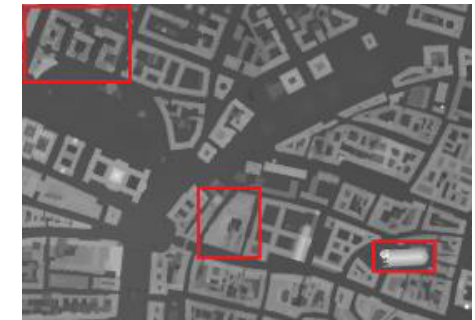
Figure 7.Visual assessment: Updated DSM from input Data. DSM has been changed in red